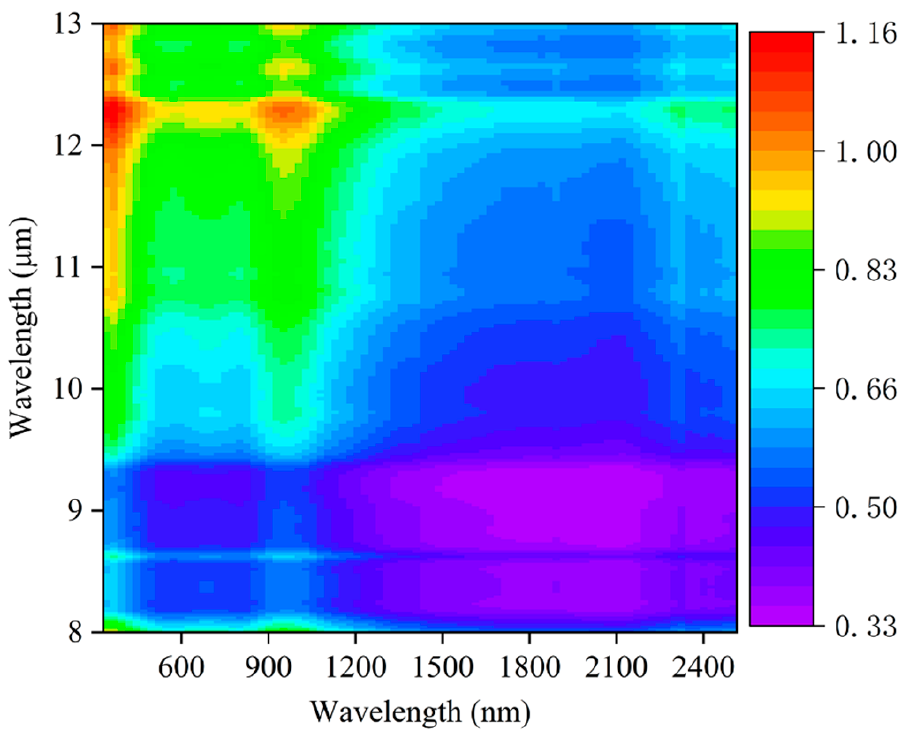
Figure 6. Mean value matrix of OPA ‐ folded results.